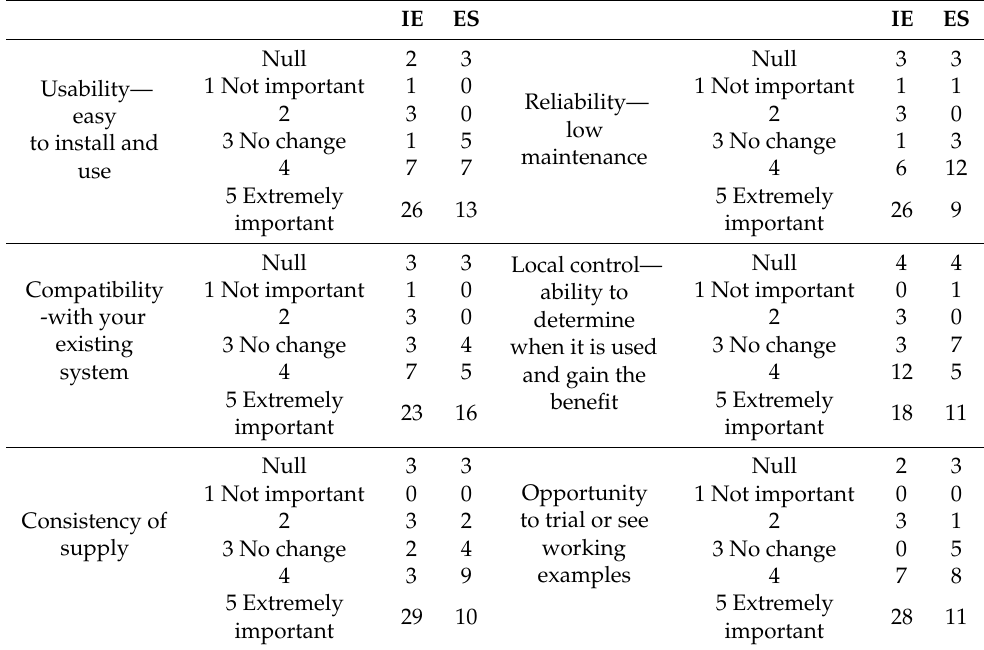
Table 6. Technical factors for the viability and adoption of MHP in Ireland (IE) and Spain